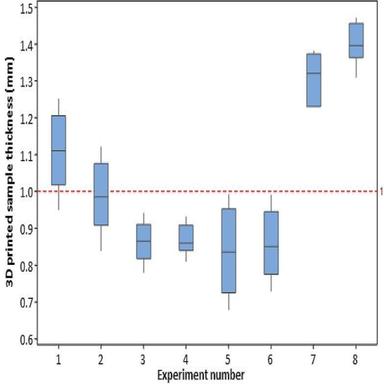
Boxplot for thickness of samples produced from each experiment listed in with a targeted sample thickness of 1 mm, shown by the dashed reference line in the graph.